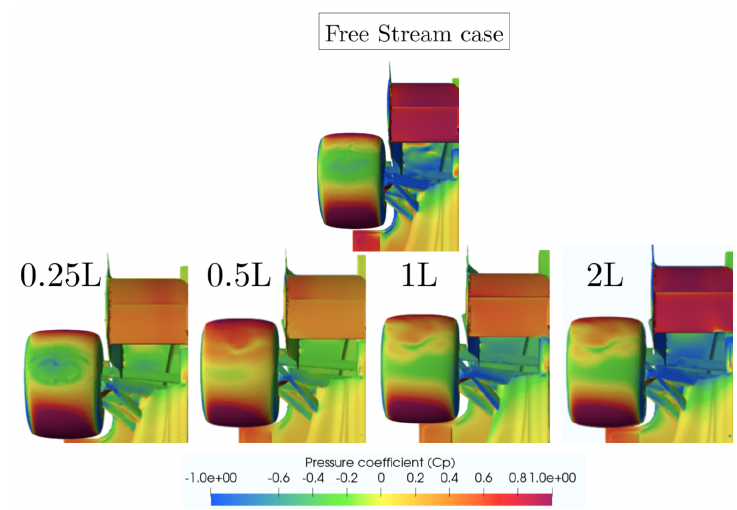
Figure 19. Pressure coefficient distribution on the rear wing of the second car at a distance of 0.25 L, 0.5 L, 1 L, and 2 L as compared to the free stream